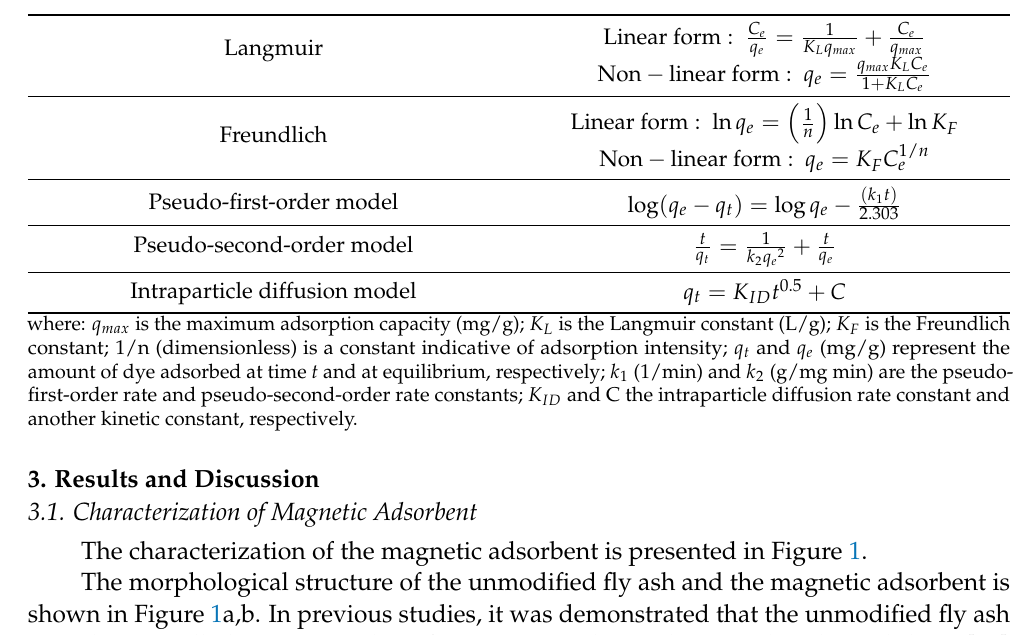
Table 2. Equations used for isotherm and kinetics adsorption